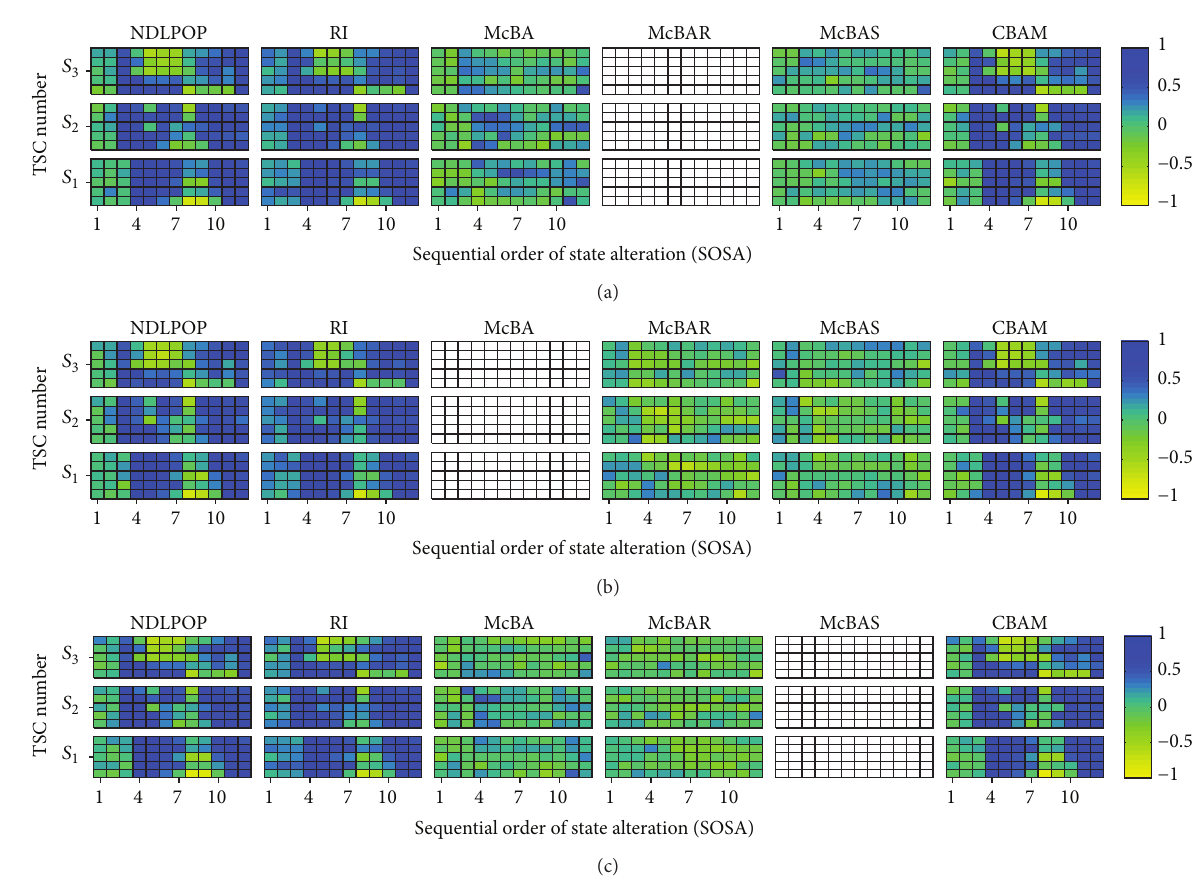
Figure 10: Dynamics of E 𝜎 𝑗,𝑘 [⋅] with 𝛿 = 3.0 with (a) McBAR, (b) McBA, and (c) McBAS as basis